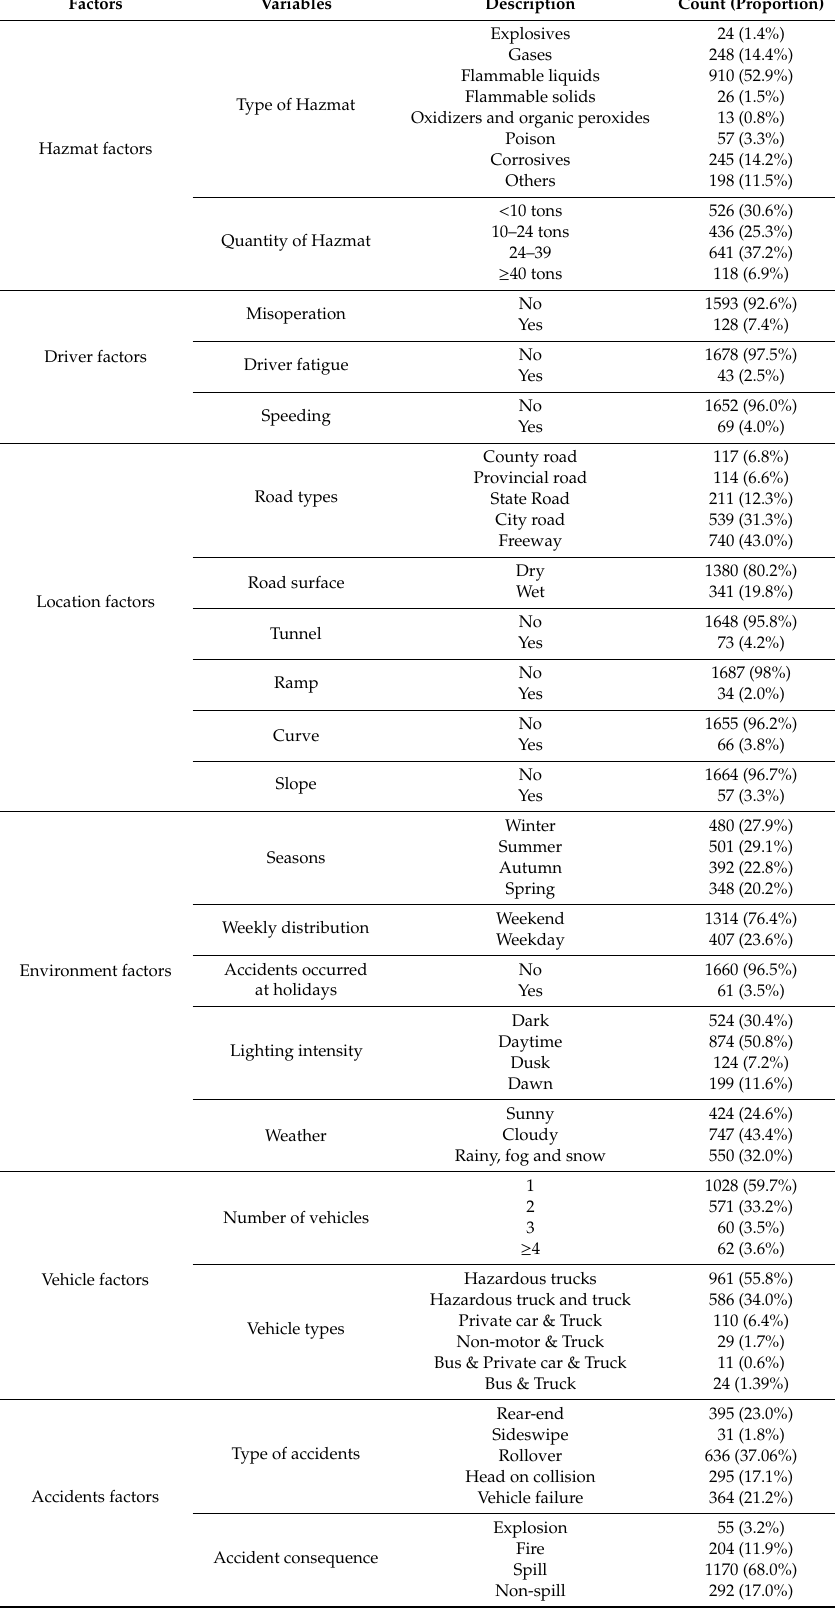
Table 1. Frequency distribution of Hazmat road transportation